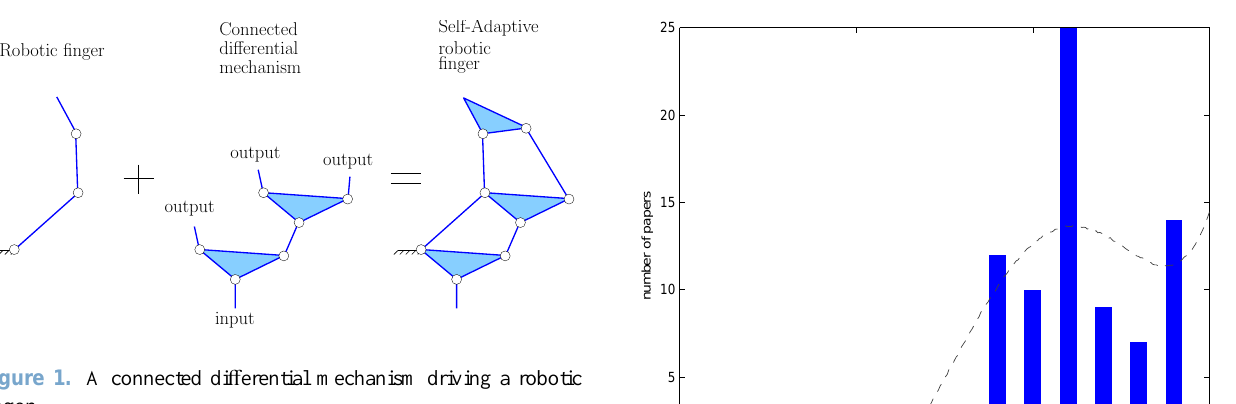
Figure 1. A connected di ff erential mechanism driving a robotic finger.